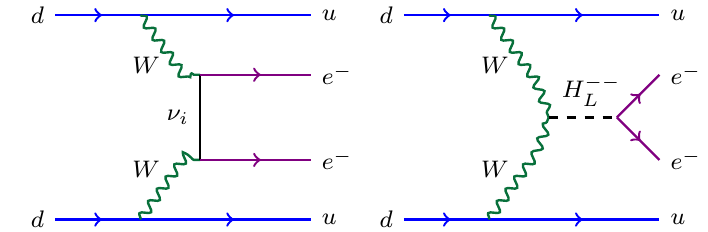
Figure 3 . Feynman diagram for the parton-level 0 (cid:23)(cid:12)(cid:12) induced by the active neutrinos (cid:23) i (left) and the LH doubly-charged scalar H (cid:6)(cid:6) (right), which correspond to the amplitudes (cid:17) (cid:23) and (cid:17) L L in eq. (2.18),